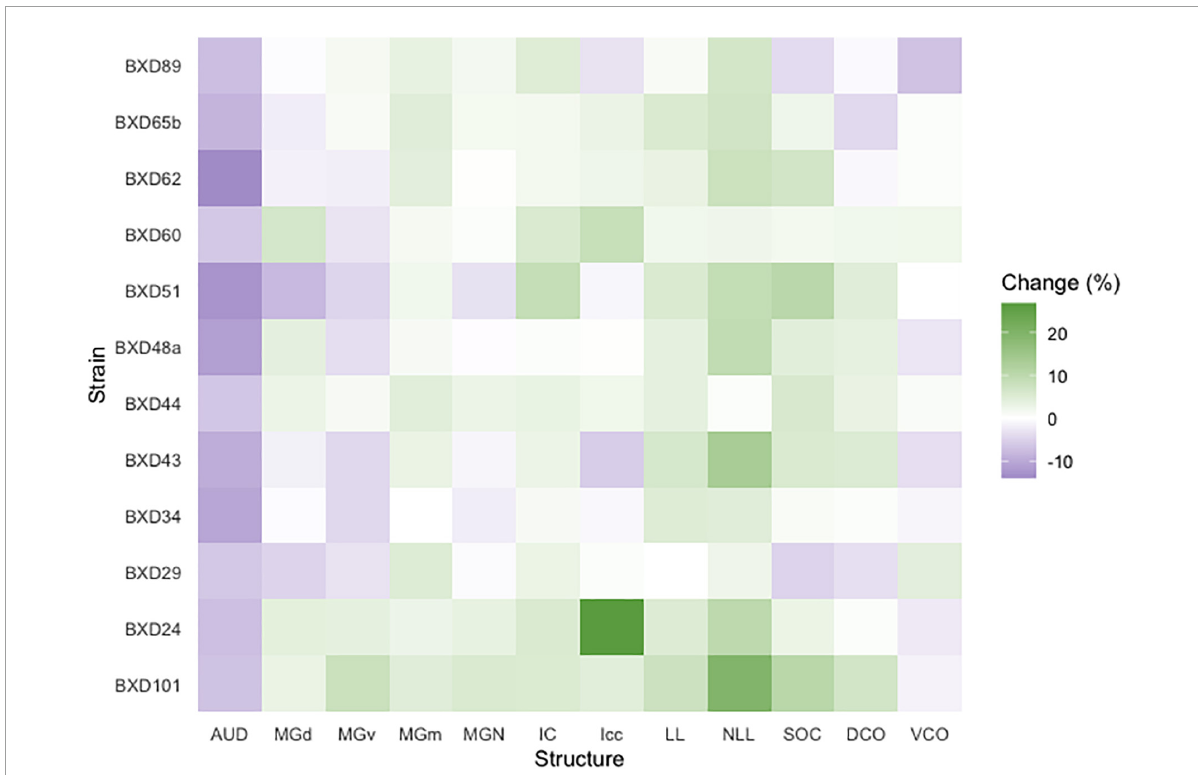
FIGURE3 Brain proportion percentage change with aging. A heatmap matrix showing percentage change in individual structure brain proportion with age in every strain evaluated. Except for the auditory cortex in which there was an age-related decline in brain proportion, there were substantial strain-based variation in all structures with aging. A range of 4–6 mice were in each age cohort and strain pairing with the exception of BXD101, in which only one mouse was imaged in the young group. AUD, Auditory cortex; MGd, Medial geniculate nucleus, dorsal part; MGv, Medial geniculate nucleus, ventral part; MGm, Medial geniculate nucleus, medial part; MGN, Medial geniculate nucleus; IC, Inferior colliculus; Icc, Inferior colliculus, central nucleus; LL, Lateral lemniscus; NLL, Lateral lemniscus, nucleus; SOC, Superior olivary complex; DCO, Dorsal cochlear nucleus; VCO, Ventral cochlear